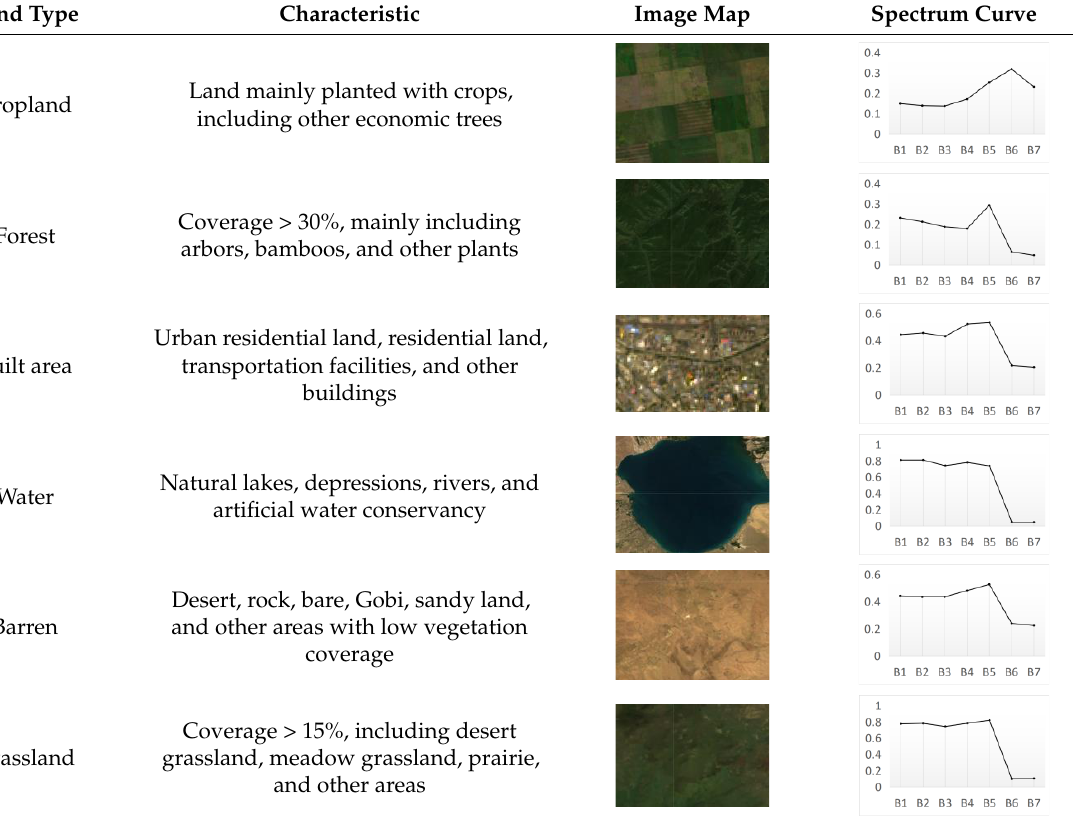
Table 2. Characteristics of land use types.